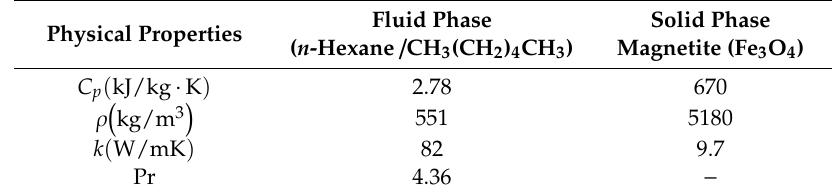
Table 1. The thermo physical characteristics of the essential fluid and